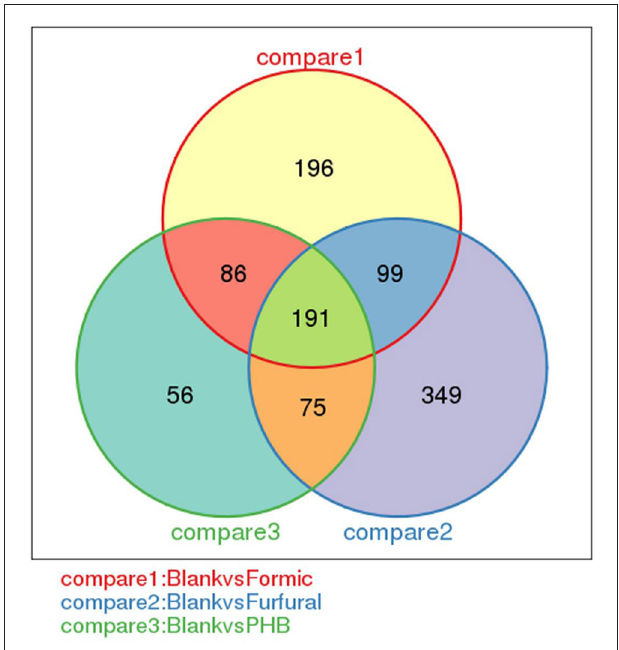
FIGURE 4 | Venn diagram showing the number of differentially expressed genes between every two samples.